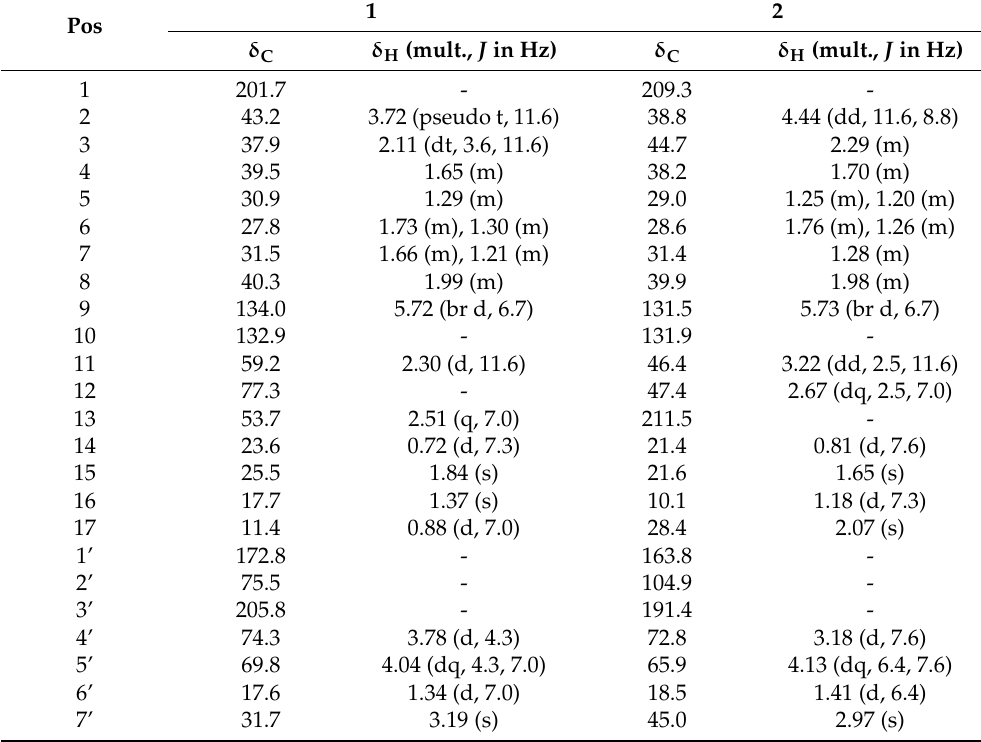
Table 1. 1 H (500 MHz) and 13 C (125 MHz) NMR data of compounds 1 and 2 in CD 3 OD and CDCl 3 ,